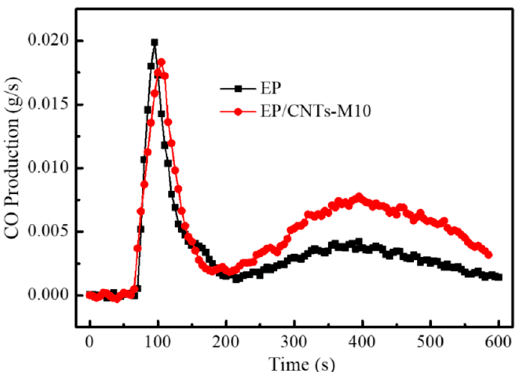
Figure 8. CO production rate versus time curves of EP and composites EP/CNTs-M10.